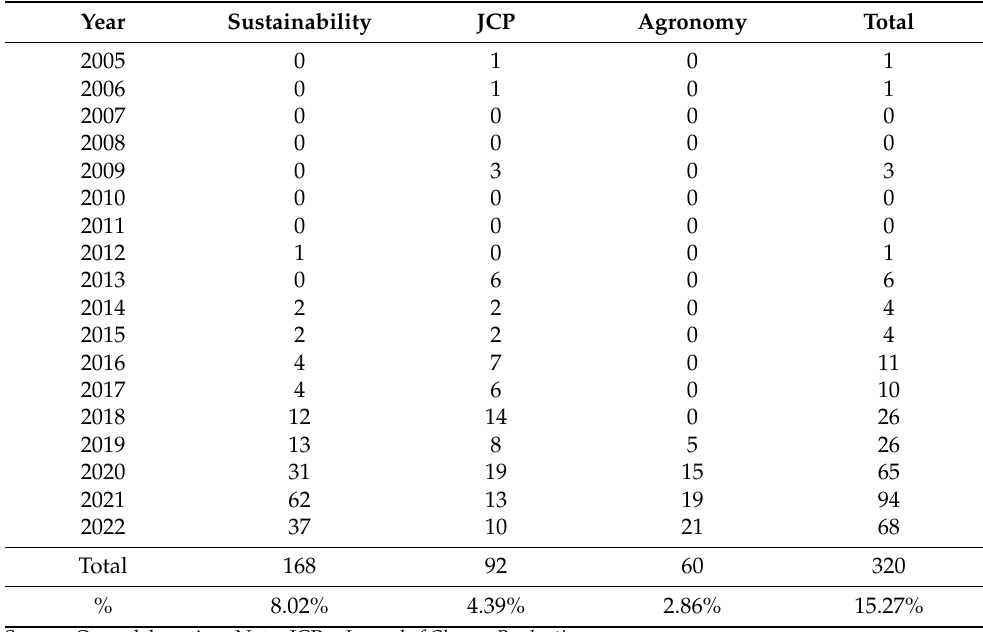
Table 2. List of articles published over time by the three leading journals identi fi ed .